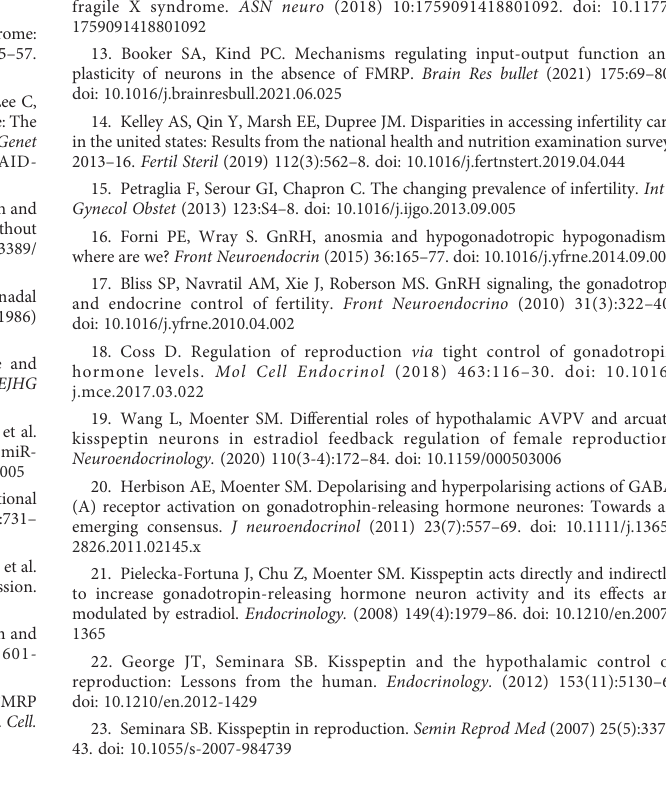
SUPPLEMENTARY FIGURE 1 Fmr1 KOfemaleshavehigher Lhb and Fshb mRNAexpression.PituitarymRNA wasanalyzedbyRT-qPCR todeterminetheexpression ofpituitaryhormones. Lhb and Fshb are increased, while expression of other hormones is unchanged. Each point represents one animal, while bars represent group means. mRNA levels were normalized to B2M mRNA. Statistical signi fi cance (p < 0.05), determined with t-test followed by Tukey ’ s post hoc test, is indicated with a *. SUPPLEMENTARY FIGURE 2 Left, speci fi city of antibody to FMRP is determined by staining hypothalamic sections from Fmr1 KO mice. Right, every 5 th coronal section containing the preoptic area of the hypothalami from WT and Fmr1 KO female mice were stained with anti-GnRH antibodies and GnRH neurons counted. Each point represents average number of neurons from all counted sections for one animal, while bars represent group